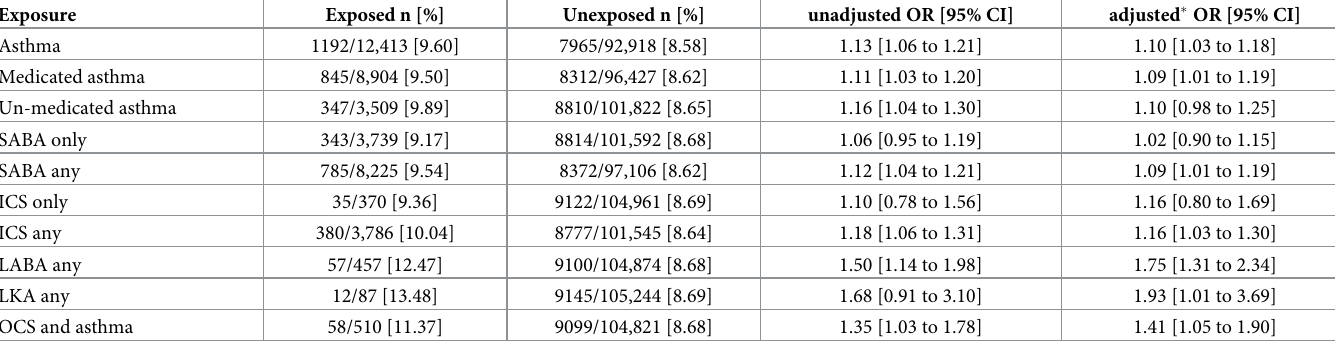
Table 4. Small for Gestational Age [SGA] < 10th centile (n = 105,331). Exposure